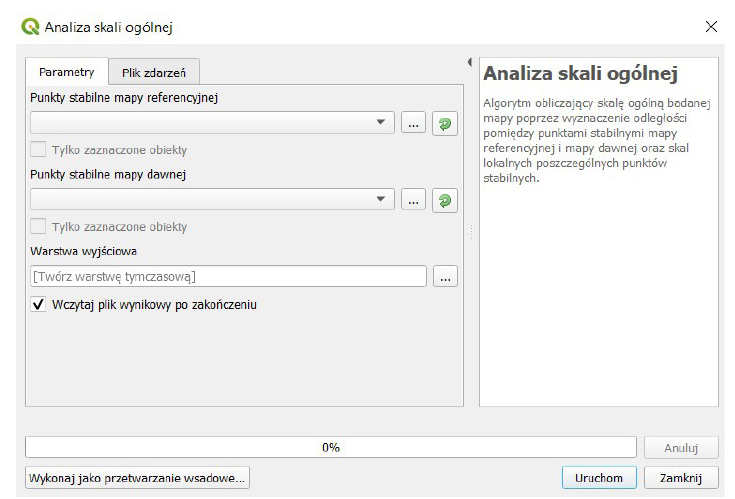
Fig. 3. Interface of the tool calculating the general scale of the studied old map (prepared by M.